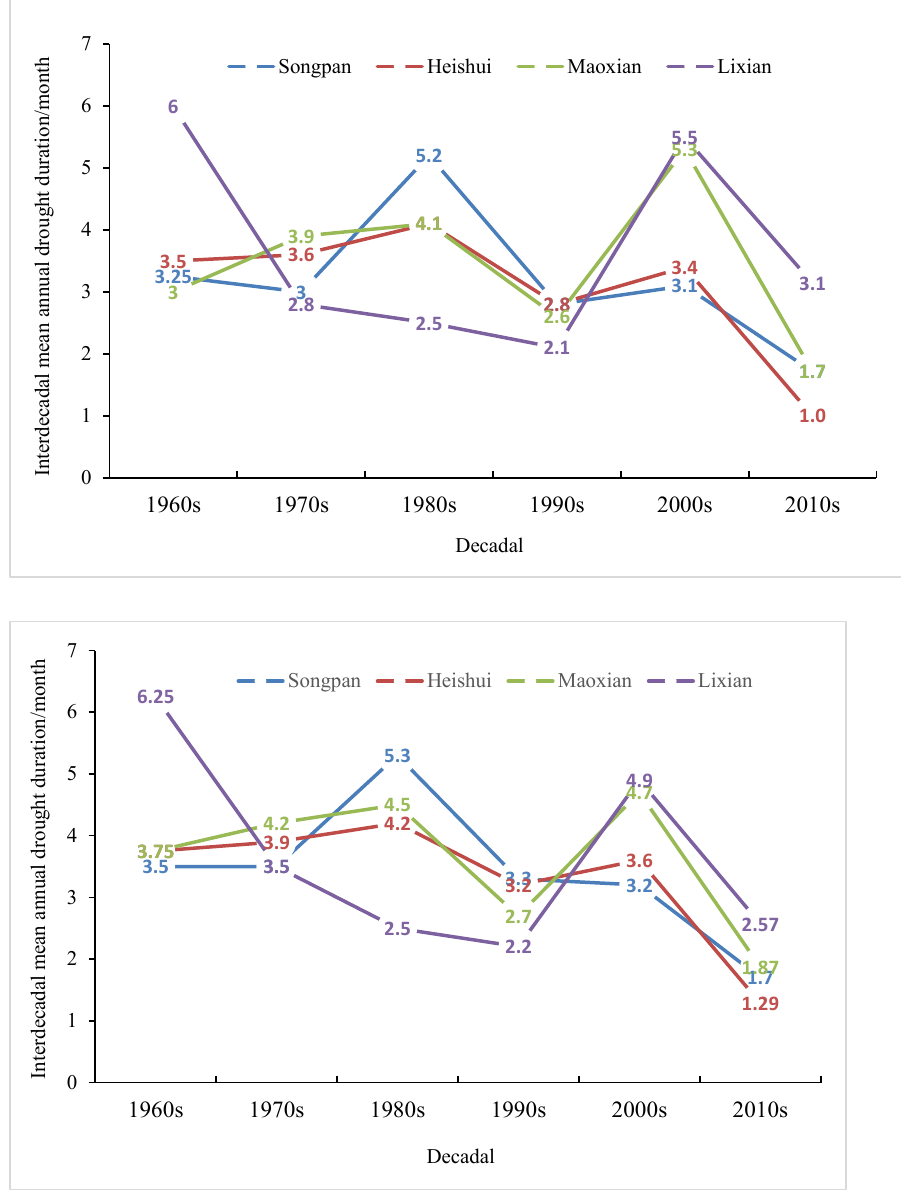
Figure 4. Variation trend of interdecadal average annual drought duration in different regions.